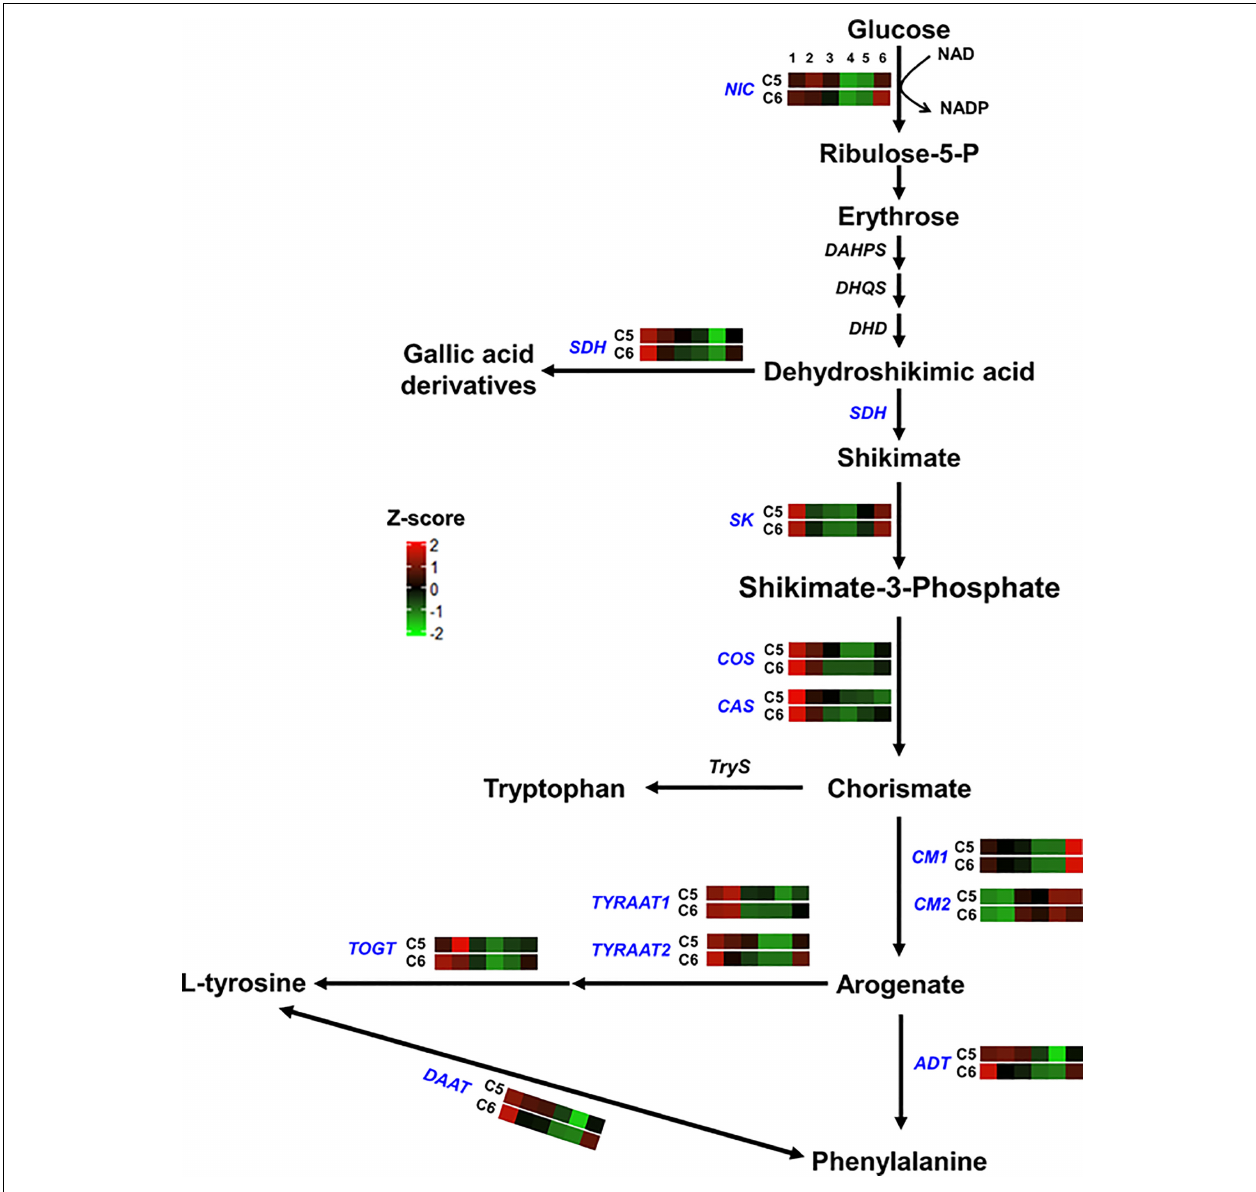
FIGURE 4 | Shikimic and amino acids pathway. The colored boxes show the accumulation pattern of genes involved in shikimic and amino acids pathway that were assessed by qPCR at different berry developmental stages, including fruit-set (1), prevéraison (2), véraison (3), postvéraison (4), ripe skin/flesh (5), and ripe seeds (6). Red boxes indicate higher levels of expression, and green boxes indicate lower expression levels. The color brightness is directly proportional to the expression ratio, according to the color scale. NIC , nicotinamidase; SDH , shikimate dehydrogenase; SK , shikimate kinase; COS , chorismate synthase; CAS , caffeine synthase; CM , chorismate mutase; TYRAAT , arogenate dehydrogenase; TOGT , tyrosine biosynthetic process; ADT , arogenate dehydratase/prephenate dehydratase; DAAT , D -amino-acid